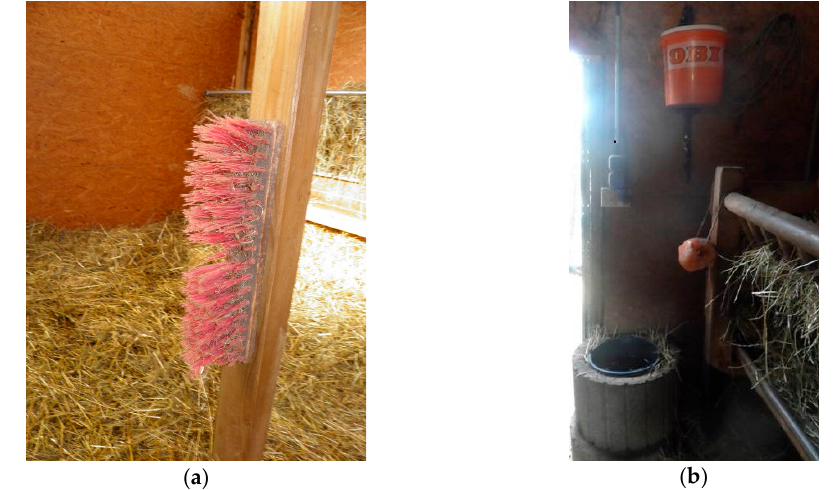
Figure 1. Epidemiological investigations on cowpox virus (CPXV) infection in four alpaca herds in Eastern Germany: ( a ) a broom for grooming, situated in the stable of flock 1 (herd III), tested positive for CPXV-specific DNA by swab sample; ( b ) the water bucket (black) in the stable of flock 3 (herd III), where a dead common vole ( Microtus arvalis ), positive for CPXV-specific DNA, was found. A total of 29 small mammals of six species were trapped at this herd (see Table 3): four striped field mice, two yellow-necked field mice, one bicolored white-toothed shrew ( Crocidura leucodon ), seven common white-toothed shrews ( Crocidura russula ), 14 common voles and one European mole ( Talpa europaea ). In none of these animals were antibodies against CPXV detected. One common vole,